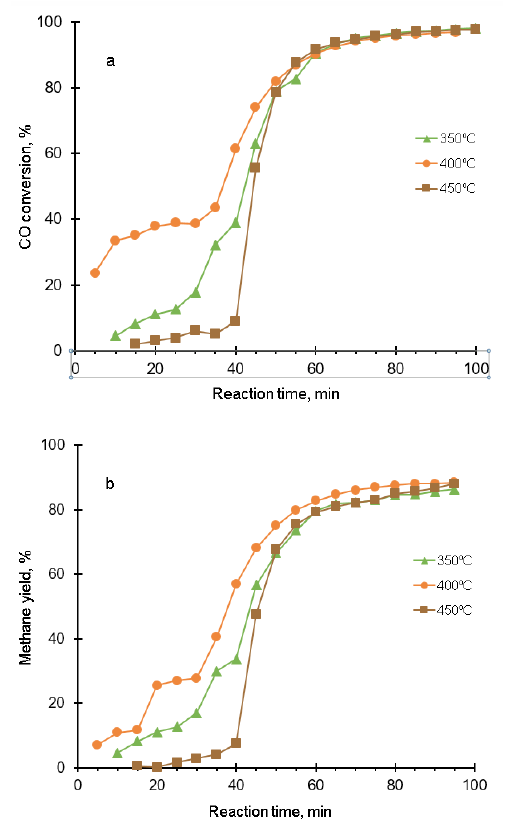
Fig. 6. CH formation T (black) and CH 4 (white) during the synthesis with the Ni/Al(N) catalysts activated at the temperatures of 350ºС, 400 ºС and 450 ºС prior methanation